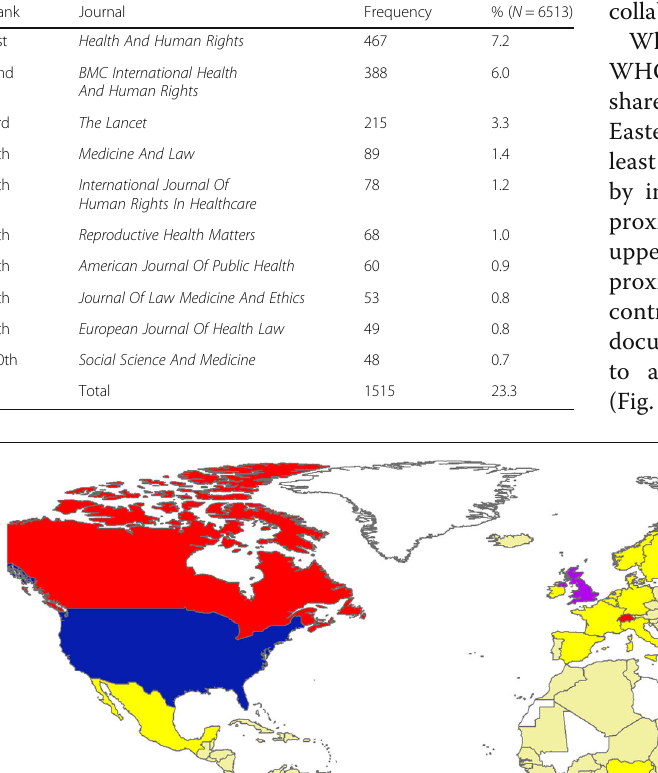
Table 1 Top 10 active journals in publishing documents on